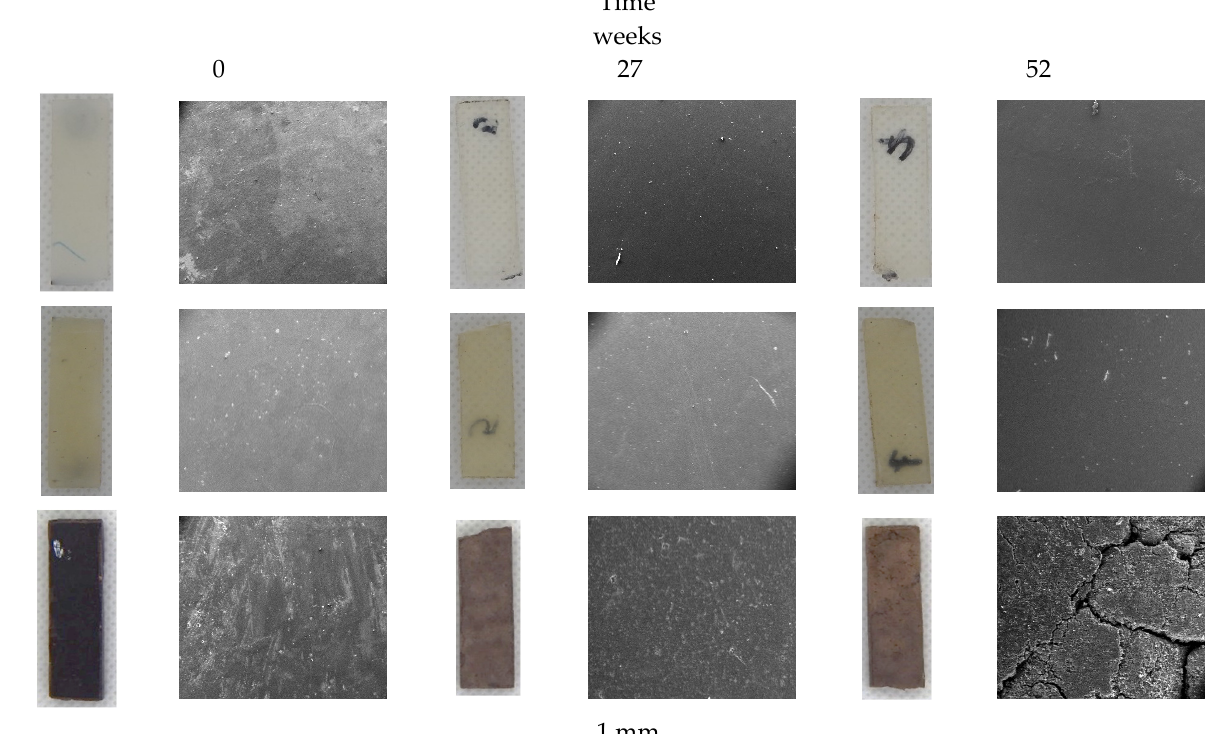
Figure 5. Optical and low magnification SEM images of PLA, MPLA, and MPN1 during biodegra- dation in soil. The scale bar refers to SEM mages.